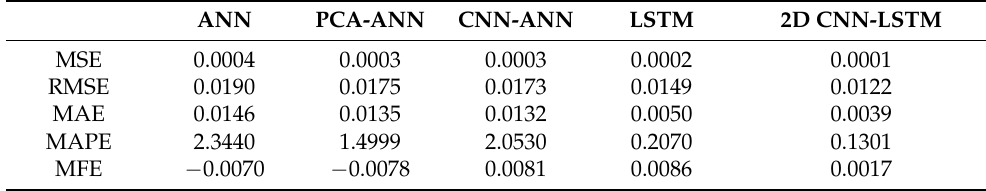
Table 8. The Amount of Each Measure for pre-COVID-19 with One-Day-Ahead